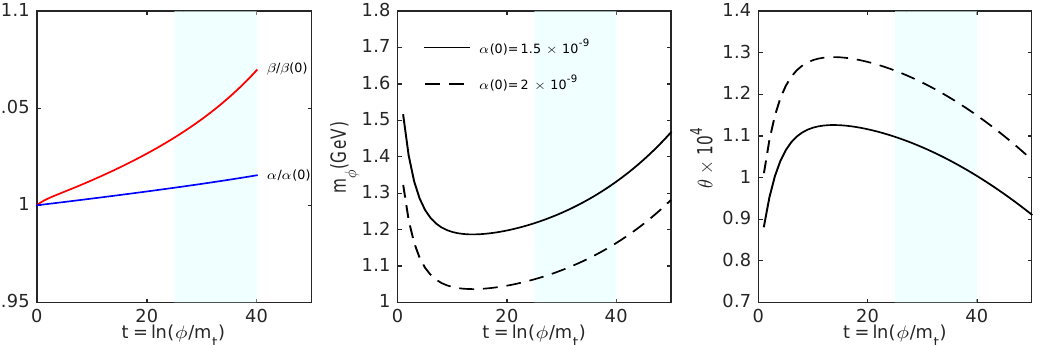
Figure 1. The evolution with the scale-dependent variable t = ln ( φ / m t ) of the radiative correc- tions for: β and α coupling constants normalised to their initial values β ( 0 ) = 1.5 × 10 − 13 and α ( 0 ) = 1.5 × 10 − 9 ( left ), the dark Higgs mass m ϕ ( middle ) and the mixing angle θ ( right ). The solid and dashed lines correspond to α ( 0 ) = 1.5 × 10 − 9 and α ( 0 ) = 2 × 10 − 9 , respectively. Other coupling constants are: ξ h ( 0 ) = 0.0064 and ξ ϕ ( 0 ) = 7.3 × 10 − 3 . The SM Higgs mass is fixed at m h = 125.09 GeV. The right-hand light blue regions indicate the slow-roll inflationary